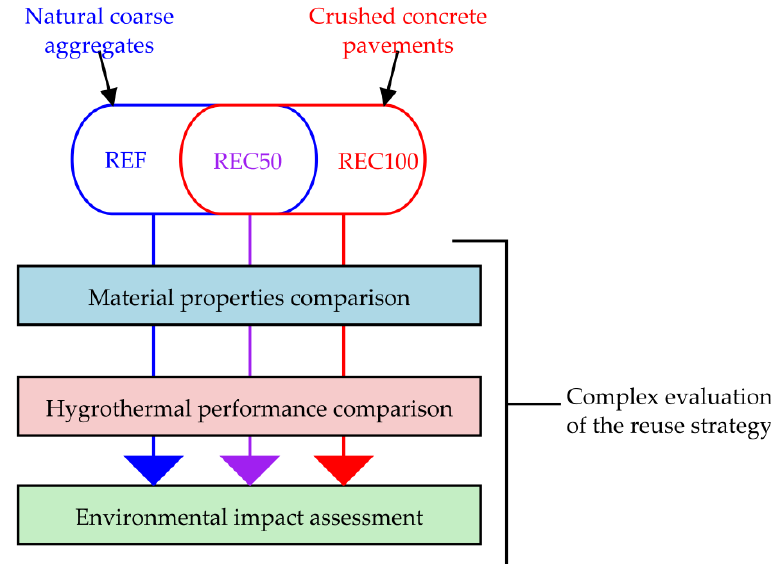
Figure 8. Scheme of the complex assessment of the reuse strategy.